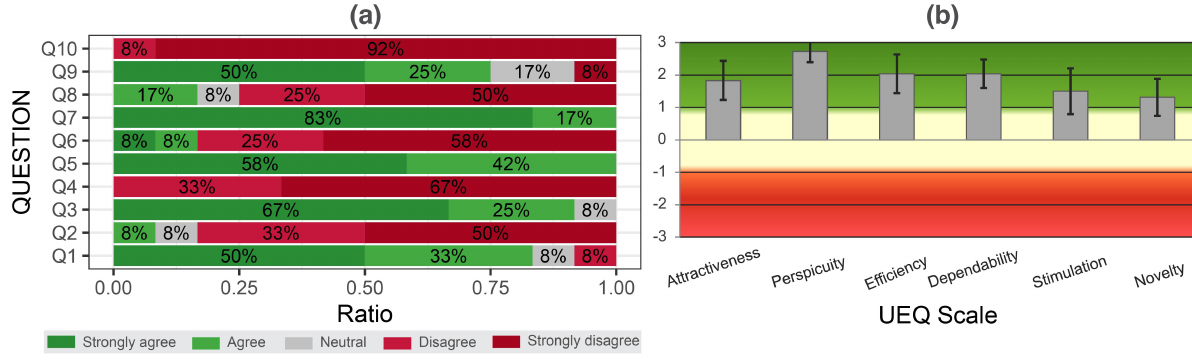
Figure 9. ( a ) Graphical representations of the System Usability Scale (SUS) Questionnaire (SUS: https://www.usability.gov/how-to-and-tools/methods/system-usability-scale.html (accessed on 31 August 2022)). ( b ) Overall results of the User Experience Questionnaire UEQ (long version) (UEQ: https://www.ueq-online.org/ (accessed on 31 August